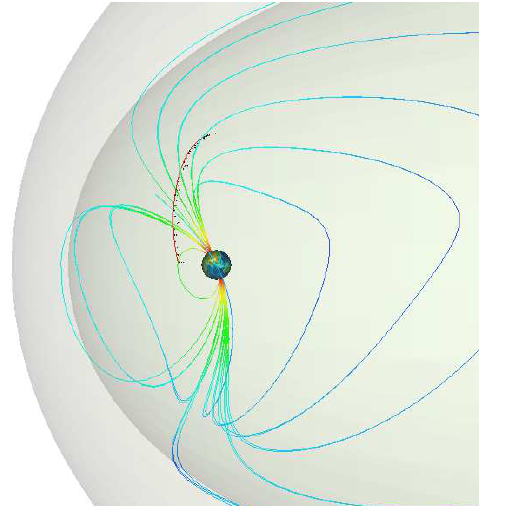
Fig. 6. Comparison of EFW and EDI data from the plasmasphere through the cusp/cleft into the polar cap. Format as in Figure 4.